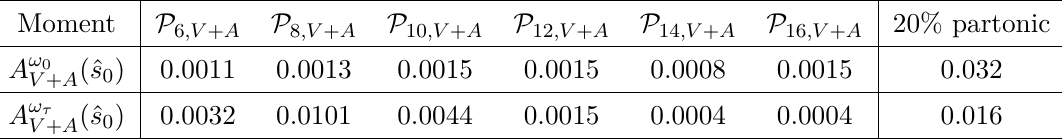
Table 3 . Estimated size of the neglected |P D,V + A | power corrections at ˆ s 0 = 1 . 55 GeV 2 , for the hypothetical divergent condensates advocated in refs. [45, 48], compared with the size of the perturbative contribution used to extract α s